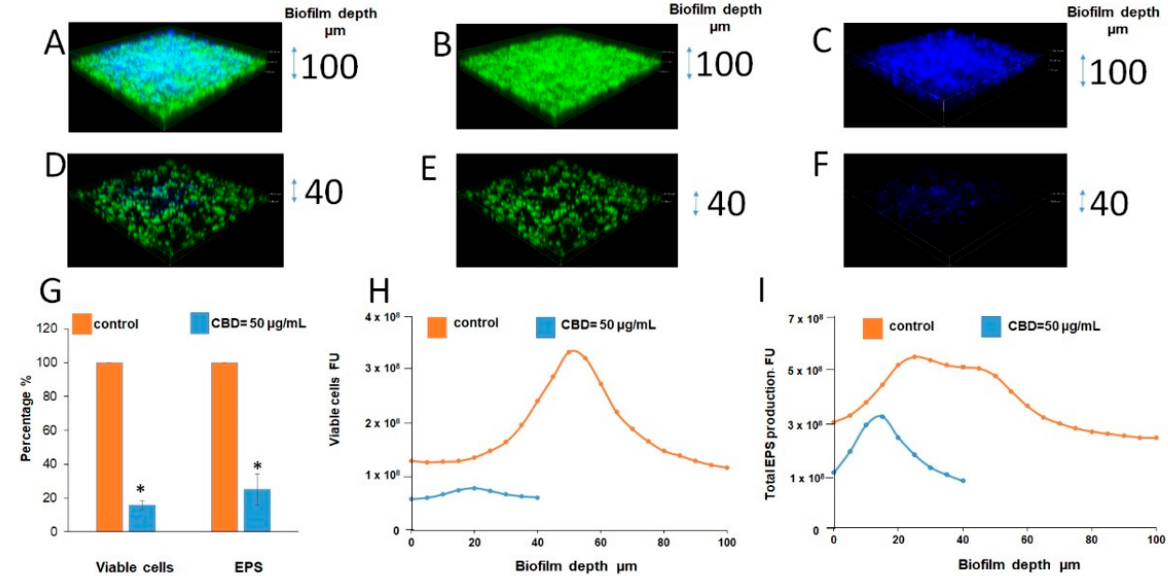
Figure 4. CLSM of biofilms. ( A – F ). CLSM 3D images of untreated and treated with CBD biofilms. ( A , D ). Merged images of metabolically active green fluorescence protein (GFP)-expressing (green color) fungal cells embedded in the extracellular polysaccharides (EPS) (blue color, ConA-stained); ( B , E ). Images of fungal cells alone (green color); C , F . Images of EPS alone (blue color); ( A – C ). Untreated control; ( D – F ). Biofilms were developed in the presence of 50 μ g/mL CBD. Z-axis of 3D images indicates biofilm thickness. Magnification 100×. ( G – I ). Quantitative analysis of total EPS production and viable cells amount in each sample was calculated as blue and green fluorescence intensity, respectively, using Image J v3.91 software. Data are presented as total EPS production ( I ) and viable cells amount ( H ) in each layer of the biofilm (5 μ m sections). Percentage of total EPS production and viable cells in biofilms treated with 50 μ g/mL CBD is presented as area under the curve (AUC) and compared to untreated control ( G ). * Significantly lower than the untreated control ( p < 0.05).